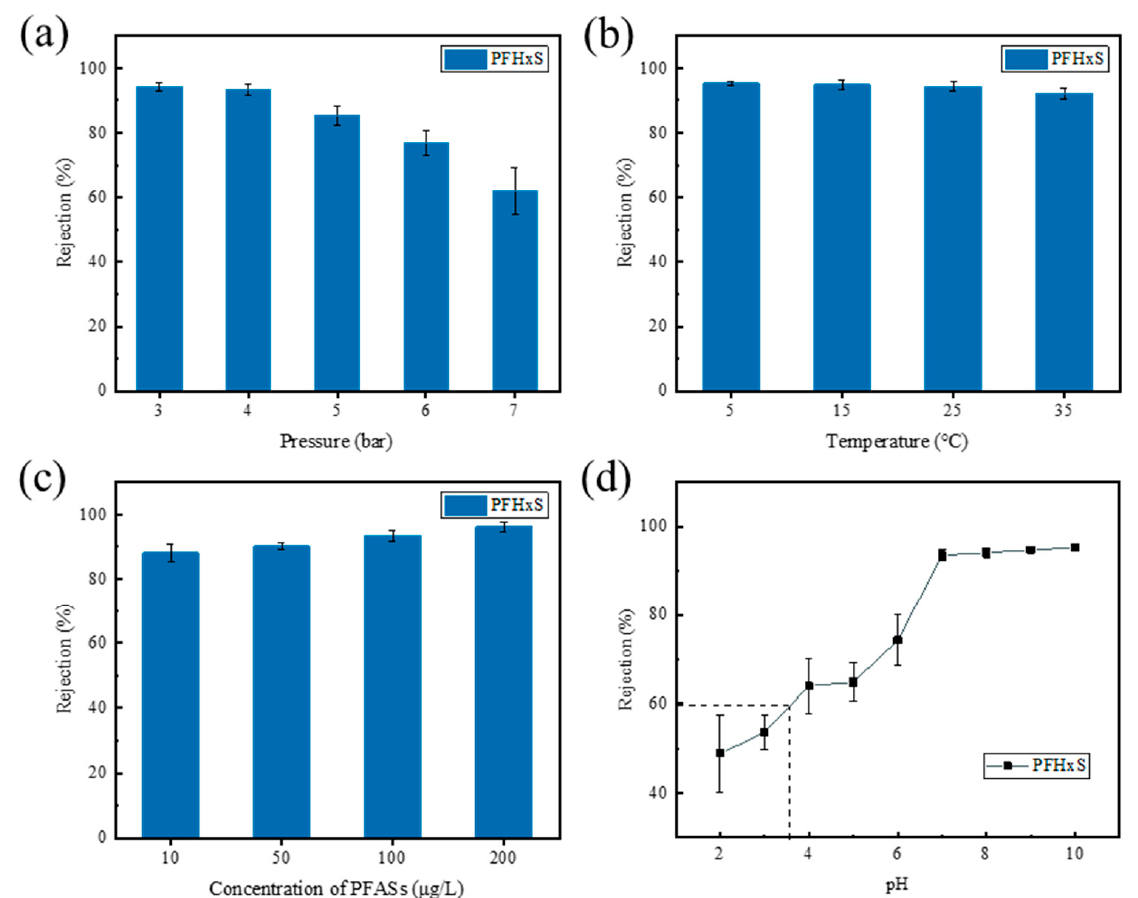
Figure 1. Effect of ( a ) pressure, ( b ) temperature, ( c ) concentration, and ( d ) PH on the removal of PFHxS by HA-TFC i NFM.